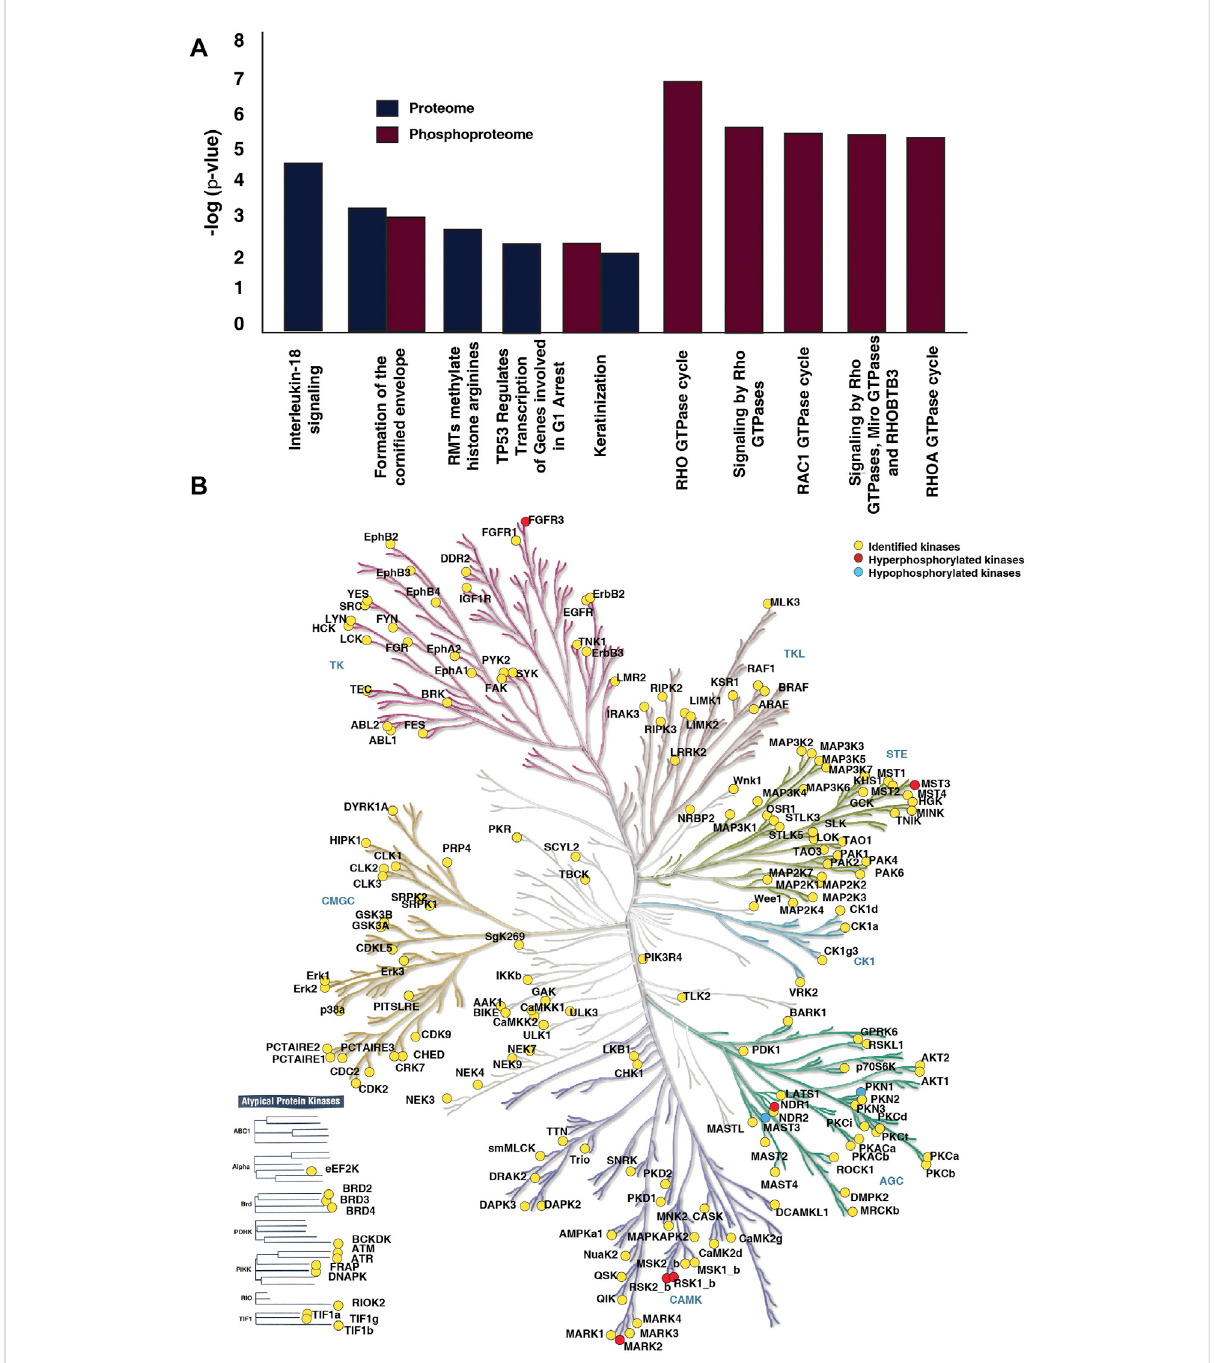
FIGURE 4 Pathways and kinases enriched in NACT resistant TSCC patients. (A) Top ten pathways signi fi cantly enriched in proteomic and phosphoproteomic data. Reactome pathway analysis of dysregulated proteins and differentially phosphorylated proteins revealed dysregulation of manypathways.Formationofcorni fi edenvelopeisthemostenrichedinproteomicdata.InphosphoproteomicdataRhoGTPasecycle,Signallingby Rho GTPases, Signaling by Rho GTPases, Miro GTPases and RHOBTB3 were top three enriched pathways. (B) Kinases identi fi ed in the dataset. The kinome map was generated using KinMap